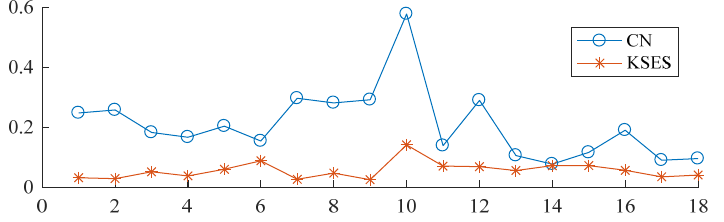
Appl. Sci. 2022 , 12 , x FOR PEER REVIEW Figure 15. CN and KSES values of each component of the envelope spectrum of the 2056th set of Figure 15. CN and KSES values of each component of the envelope spectrum of the 2056th set of data. Figure 15. CN and KSES values of each component of the envelope spectrum of the 2056th set of Figure 15. CN and KSES values of each component of the envelope spectrum of the 2056th set of data. data. data.